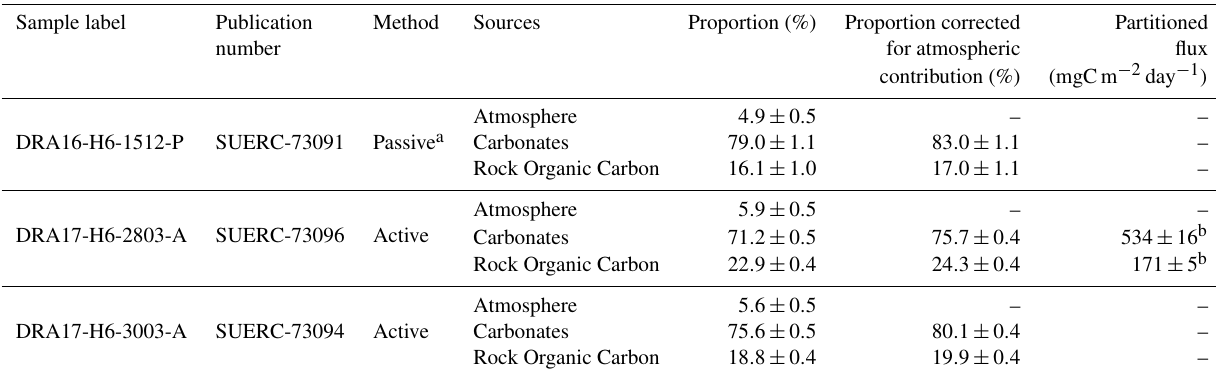
Table 4. Isotope mass balance results. Sample